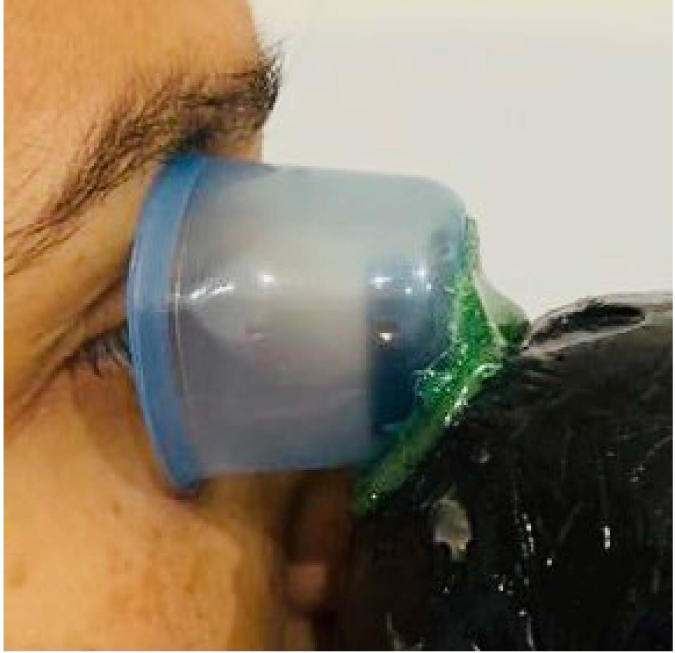
Figure 2. The DEvice© ocular hygrometer cup